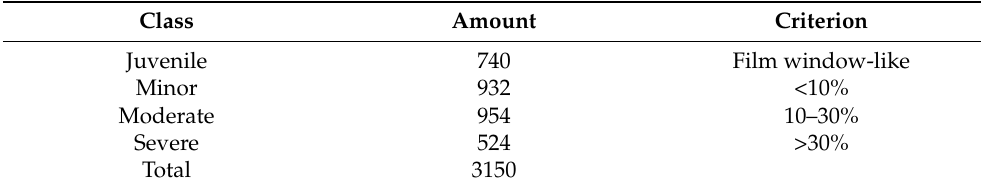
Table 1. Initial feed severity of S. frugiperda anchor distribution. Class Amount Criterion